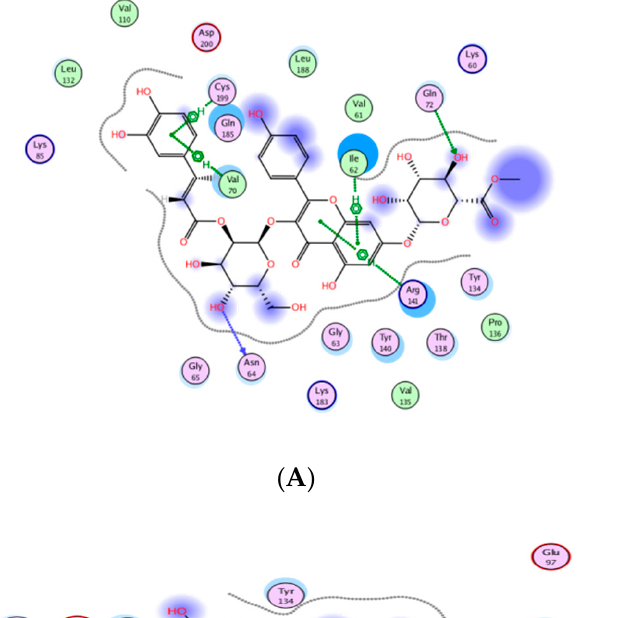
Figure 13. The 2D and 3D molecular docking presentation of the possible binding conformations of 19 ( A , B ), 20 ( C , D ), and 21 ( E , F ) in the IL-1 β binding site using PDB 6Y8M. The interacting residues are highlighted in the yellow stick model with H-bonds and H-pi interactions are presented as green and red dotted lines, respectively, having their distances illustrated in Å.